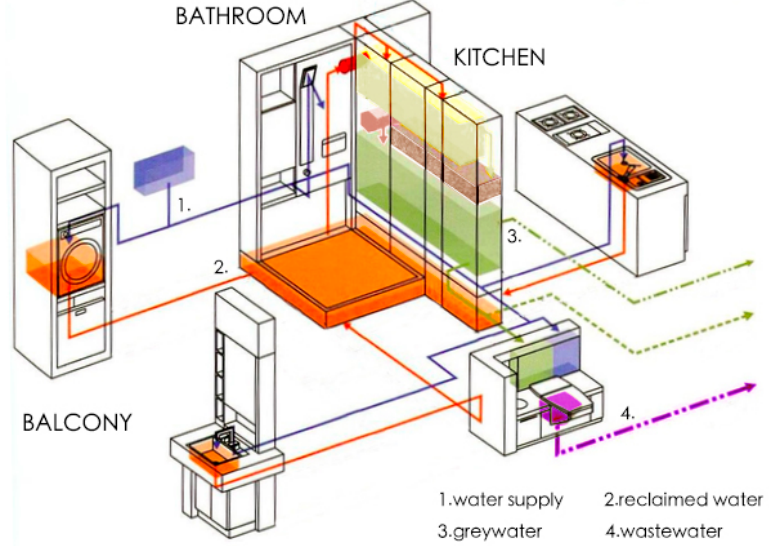
Figure 2. Conceptual diagram of Interior Customized Greywater System (ICGS).